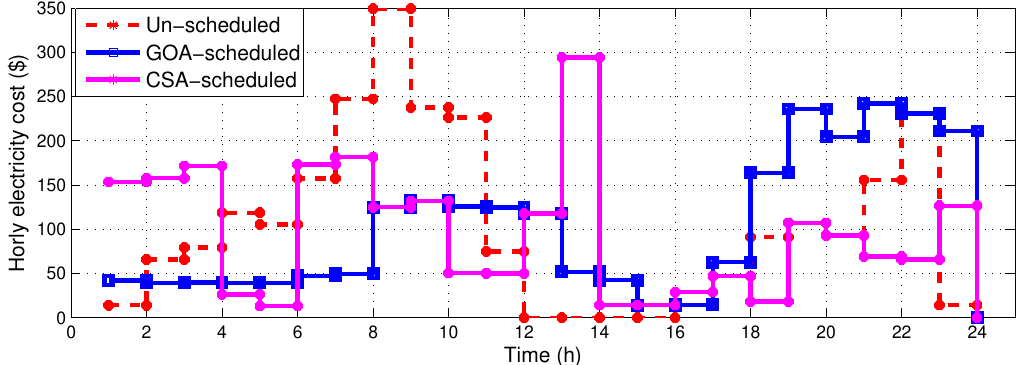
Figure 5. Hourly consumed energy